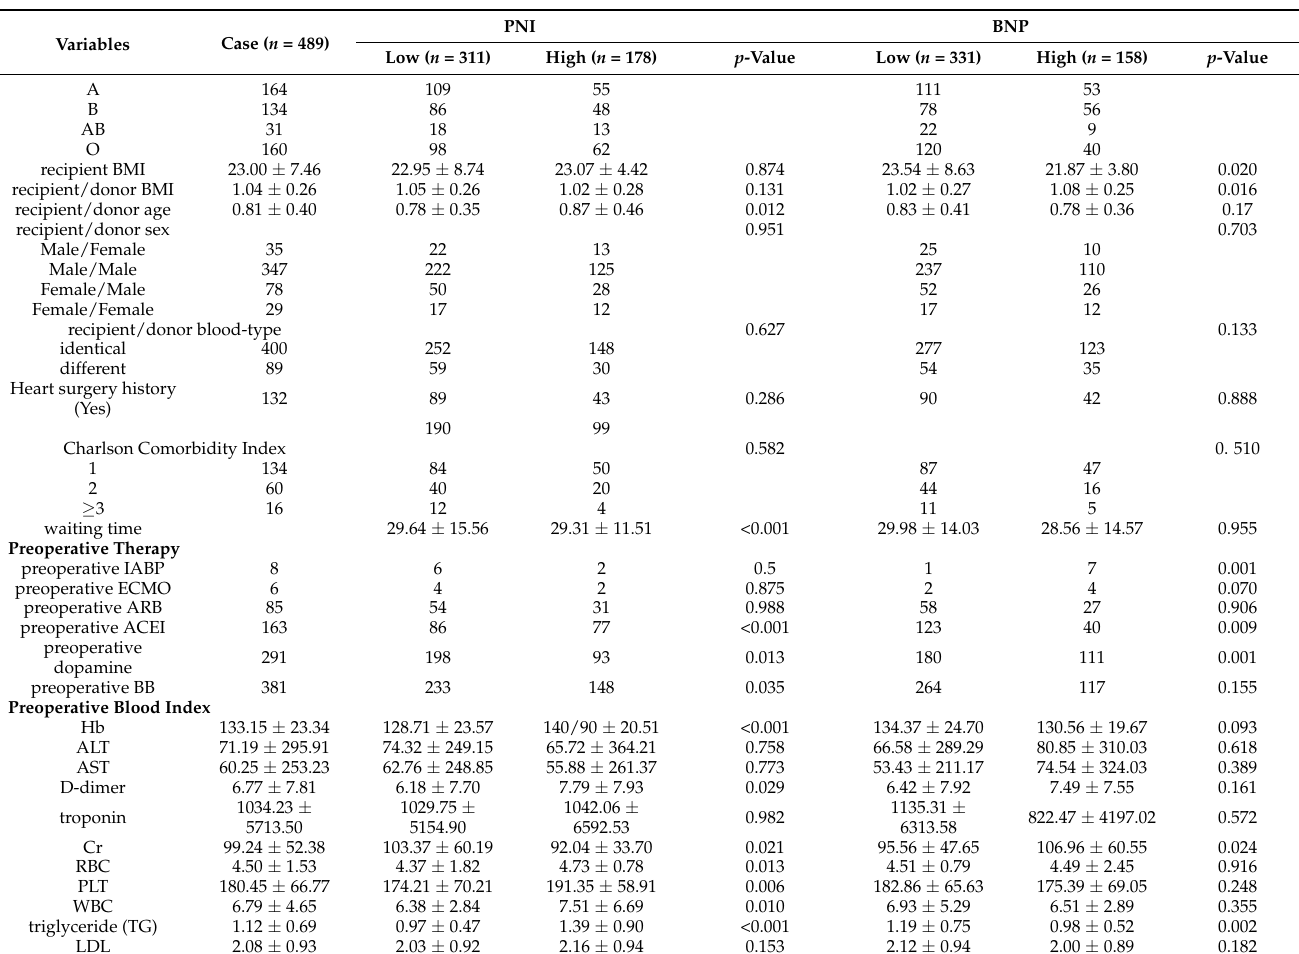
Baseline clinical characteristics were shown and compared between two groups of each blood index separately (Table 1). Higher PNI was significantly related with younger age ( p = 0.005), larger recipient/donor age ratio ( p = 0.012), shorter waiting time ( p < 0.001), more preoperative ACEI use ( p < 0.001), less preoperative dopamine ( p = 0.013), more pre- operative BB use ( p = 0.035), lower Cr level ( p = 0.021), higher D-dimer, Hb, RBC, PLT, WBC, and triglyceride ( p = 0.029, p < 0.001, p = 0.013, p = 0.006, p = 0.01, and p < 0.001). In addition, lower BNP was significantly associated with younger age ( p = 0.029), higher recipient BMI ( p = 0.02), lower recipient/donor BMI ( p < 0.016), less preoperative IABP use ( p = 0.001), more preoperative ACEI use ( p = 0.009), less preoperative dopamine use ( p = 0.001), lower Cr level ( p = 0.024), and higher triglyceride level ( p = 0.002). There was no significant difference in other variables between two groups. 3.3. Univariate and Multivariate Cox Analysis of OS of Patients with HTx The results presented the relationships between blood biomarkers and OS. The low PNI group had a more significant OS than that of high PNI group ( p < 0.001, Figure 3a), whereas the high BNP group was observed with worse OS than that of low the BNP group ( p < 0.001, Figure 3b). Multivariate analysis showed that older age (HR 1.025, 95%CI, 1.009–1.042, p = 0.002), low PNI level (HR 0613, 95%CI 0.378–0.993, p = 0.047), high BNP level (HR 1.542, 95%CI 1.057–2.248, p = 0.024), and long waiting time (HR 1.014, 95%CI, 1.003–1.026, p = 0.012) were the independent protective factors for the prognostic of heart transplantation (Table 2).